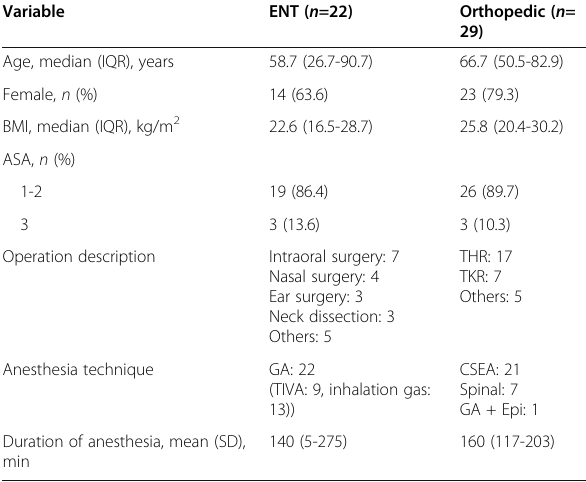
Table 2 Patient demographics at Miyazaki